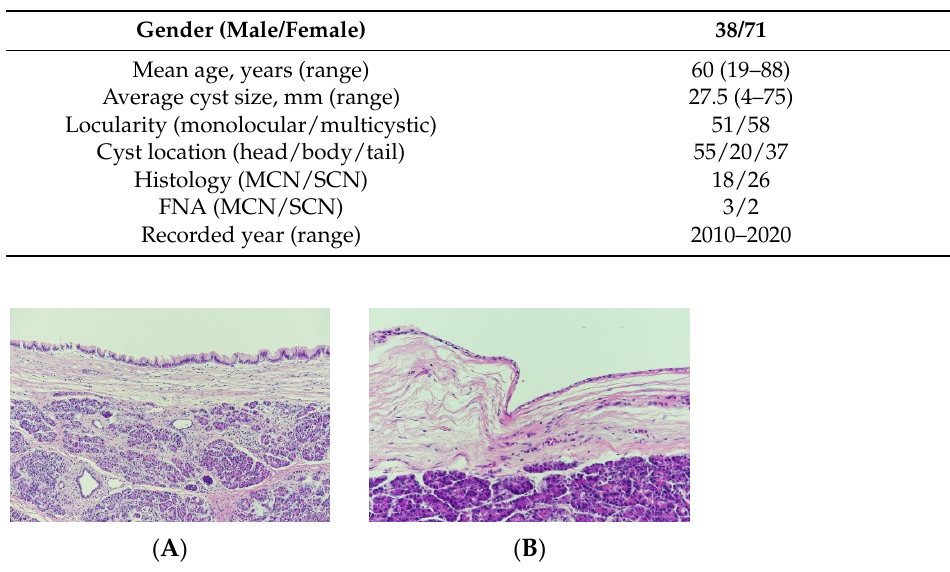
Figure 1. Histology images (200×) for ( A ) mucinous cystic neoplasm and ( B ) serous cystic neo- plasm